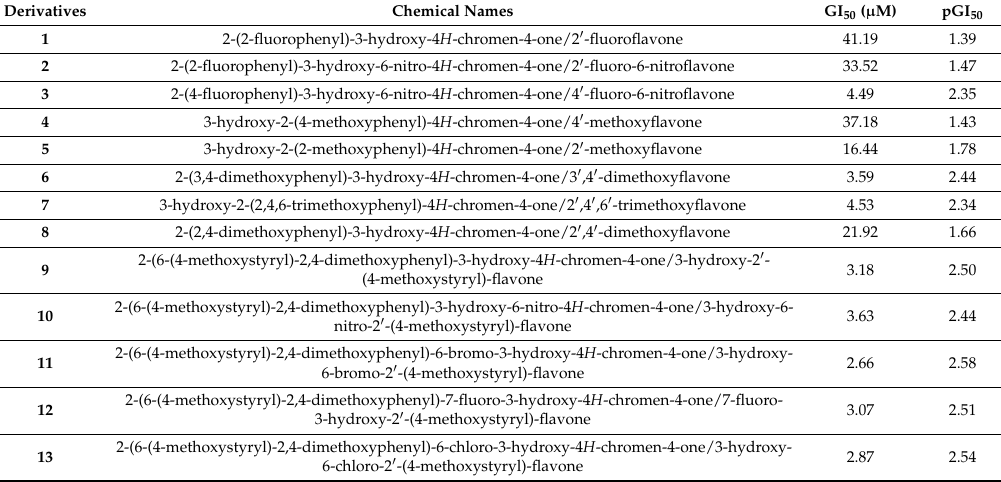
Table 1. Names of synthetic flavone derivatives 1 – 36 , and their half-maximal cell growth inhibitory effect (GI 50 ) and the negative logarithmic scales of GI 50 values (pGI 50